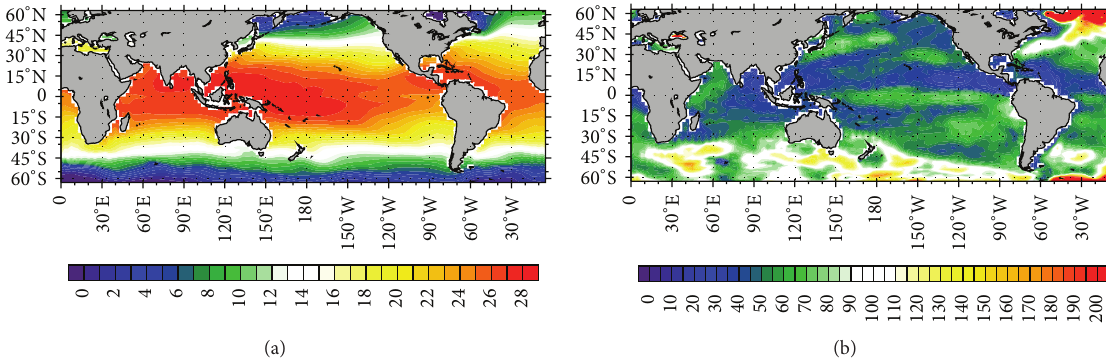
Figure 3: (a) Annual-mean temperature field in the mixed layer of 2001 from Exp. 1; (b) annual-mean mixed layer depth of 2001 from Exp. 1. Mixed layer depth here is defined as the depth that has a 0.3 ∘ C temperature jump to the sea surface temperature. Temperatures ( ∘ C) are vertically averaged through the mixed